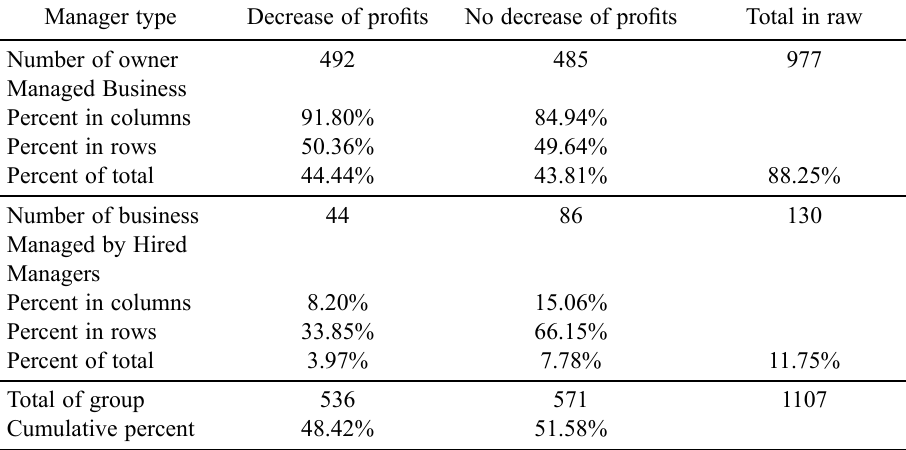
Table 2. Decrease of profits in 2009 by type of manager